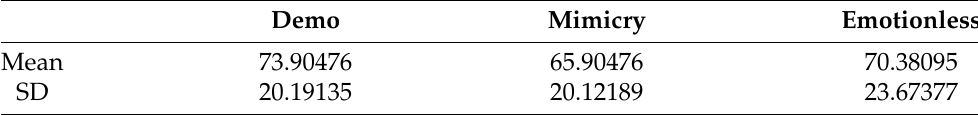
Table 6. Average trial completion time by mode in